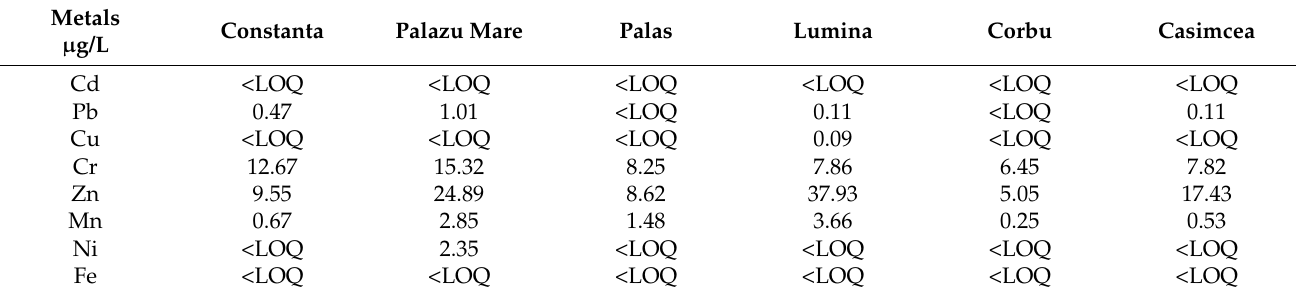
Table 3. Values of metal concentrations for the studied samples.